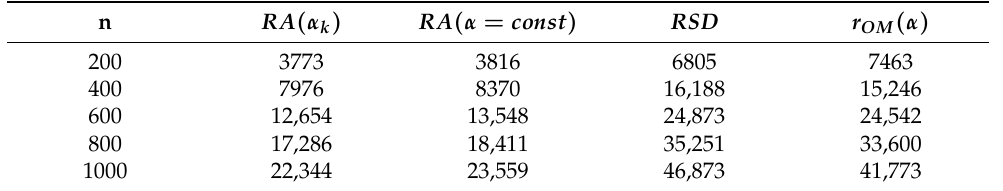
Table 7. Function f 5 ( x ) minimization results with subgradient